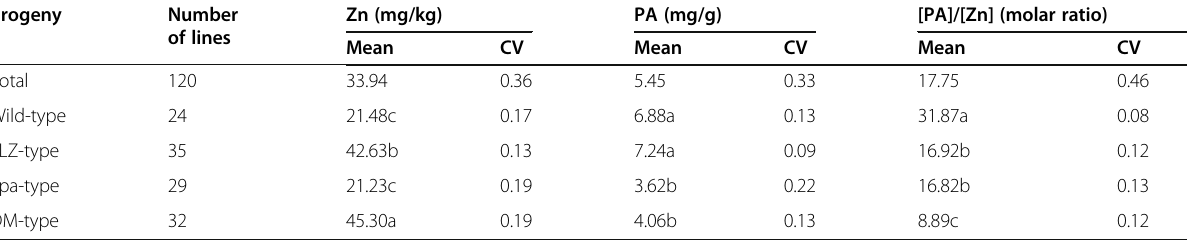
Table 3 Zn, phytic acid and their molar ratio in the brown rice of cross-bred progenies Progeny